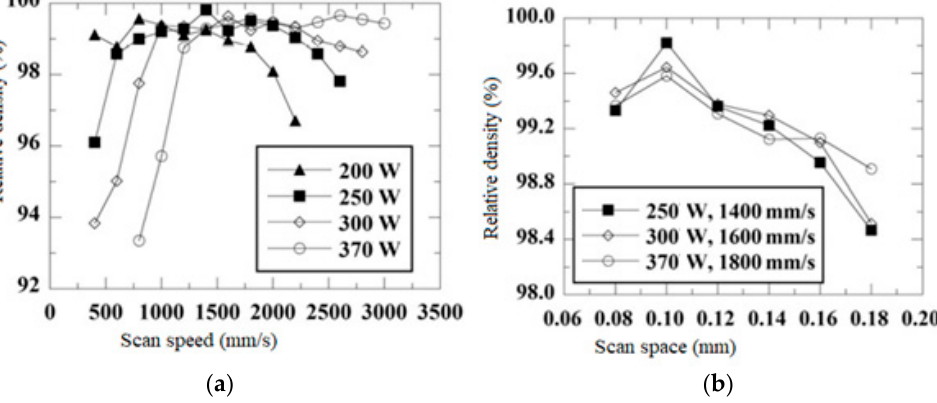
Figure 5. Relative density of SLM as ( a ). A function of scan speed and laser power, ( b ). Scan spacing. (Reused by permission form [107], License number 5464270902364). (Reused by permission form [107], License number